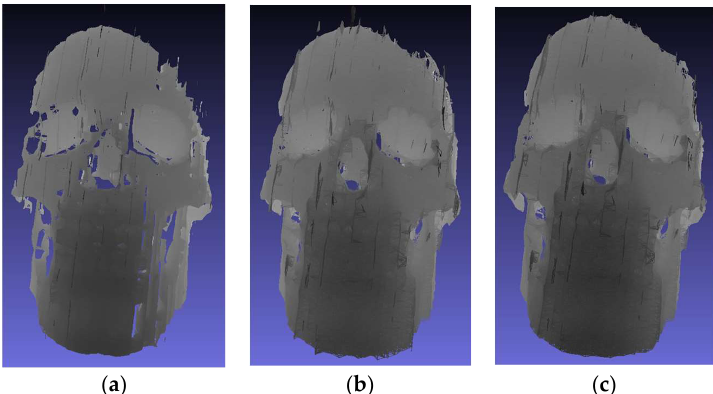
Figure 9. Results of the 3D mesh formation ( a ) Raw mesh for a single view ( b ) Raw mesh for the integration of five point clouds registered after the ICP algorithm ( c ) Refined mesh using the MeshLab software for the integration of five point clouds registered after the ICP algorithm. Figure 10a–c show the merged point clouds, 3D model and the surface divergence between the merged point clouds and the 3D model respectively. The mean distance between the merged point clouds and the 3D model was 0.94 mm while the standard deviation was found to be 0.15 mm.